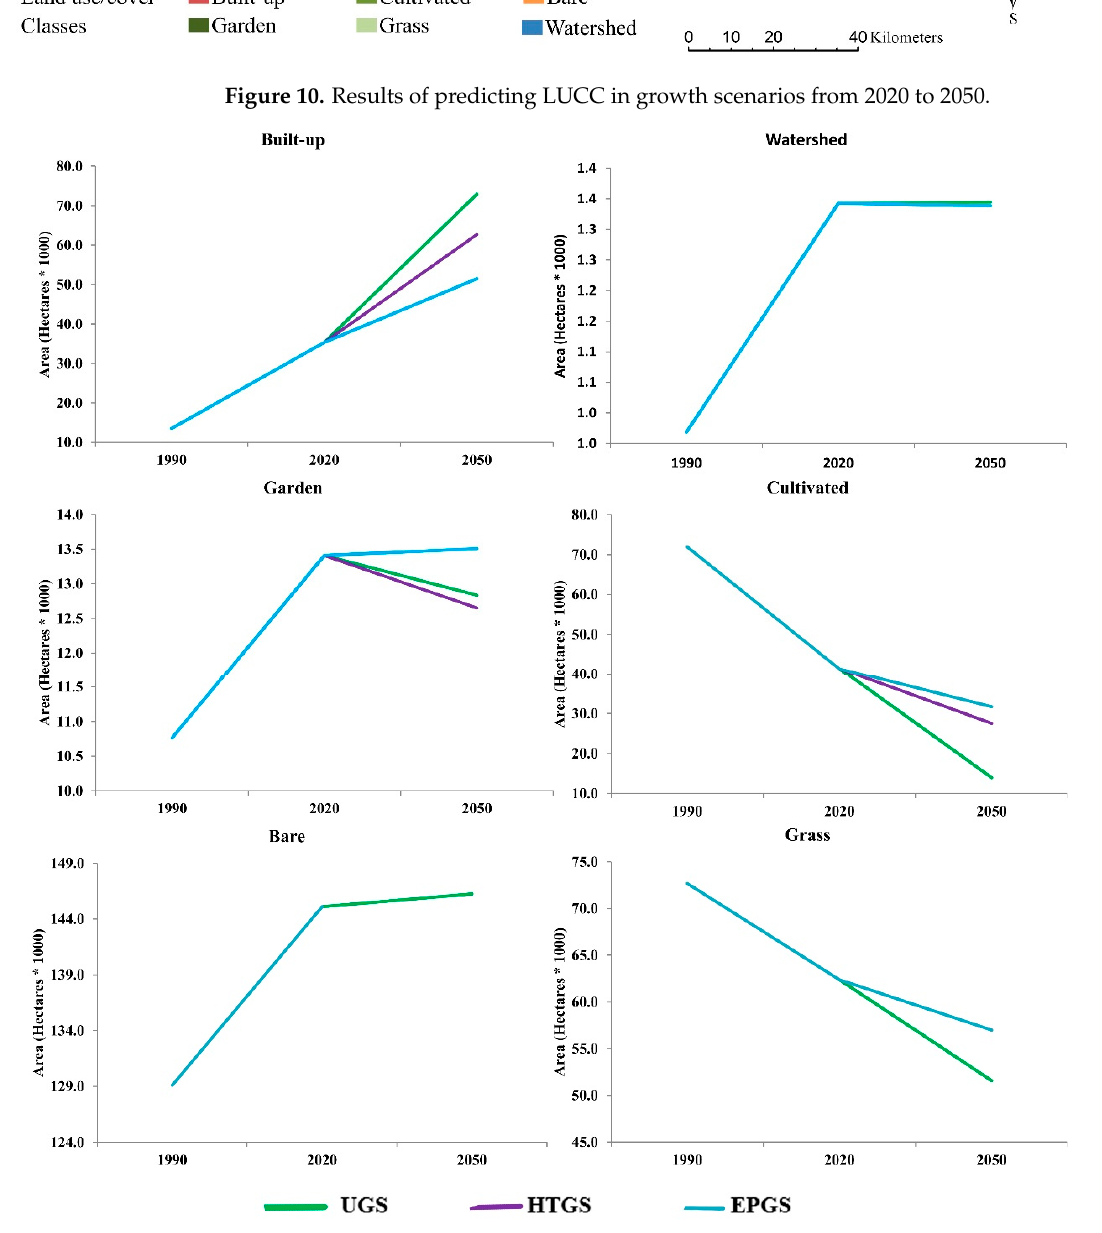
Figure 11. Results of land change forecasts from 1990 to 2050.